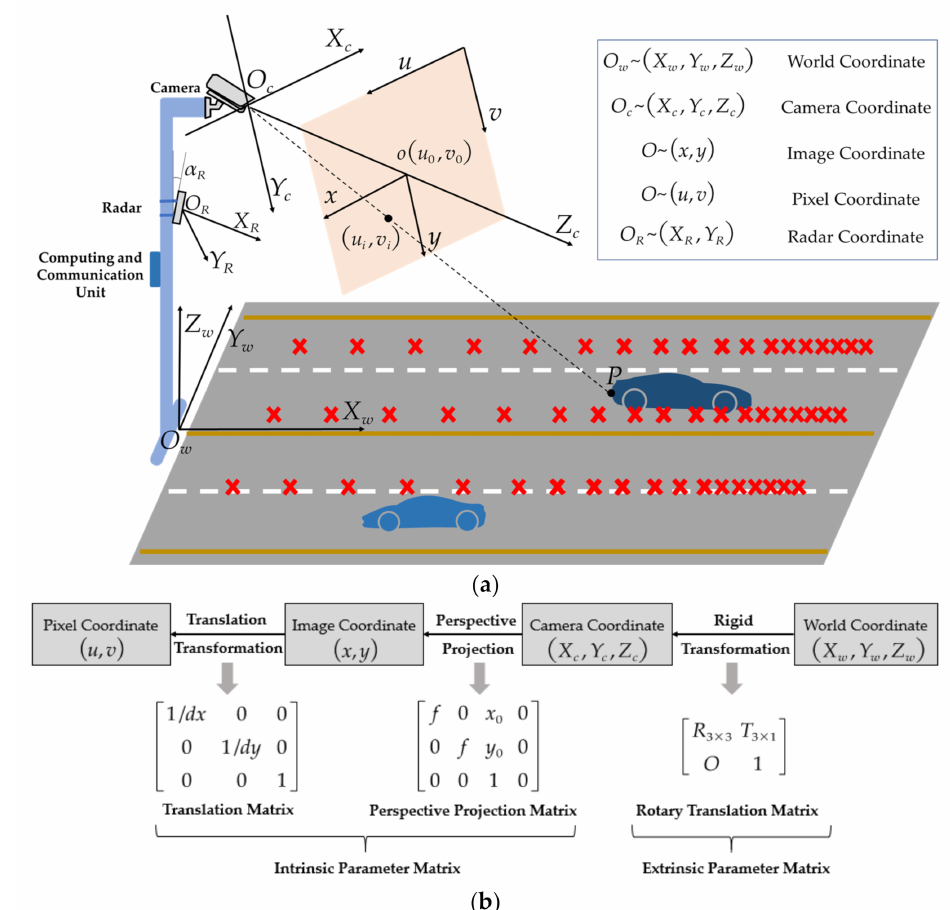
Figure 3. ( a ) Joint calibration method of roadside cameras and millimeter-wave (MMW) radar; ( b ) coordinate mapping from the world coordinate system to the pixel coordinate